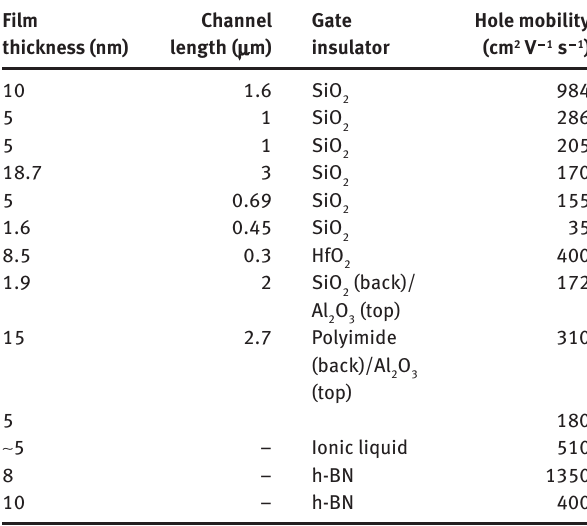
Table 1: BP-based FETs and their